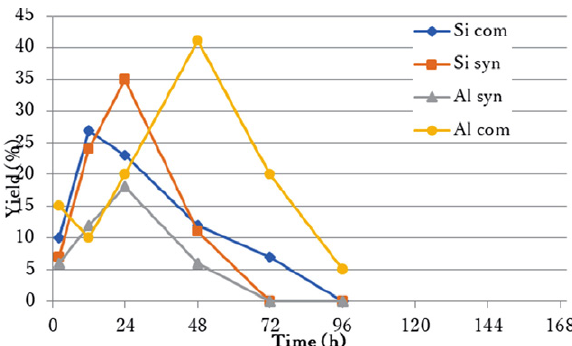
Figure 8. Evaluation of the overall efficiency according to the nature of the catalyst used.